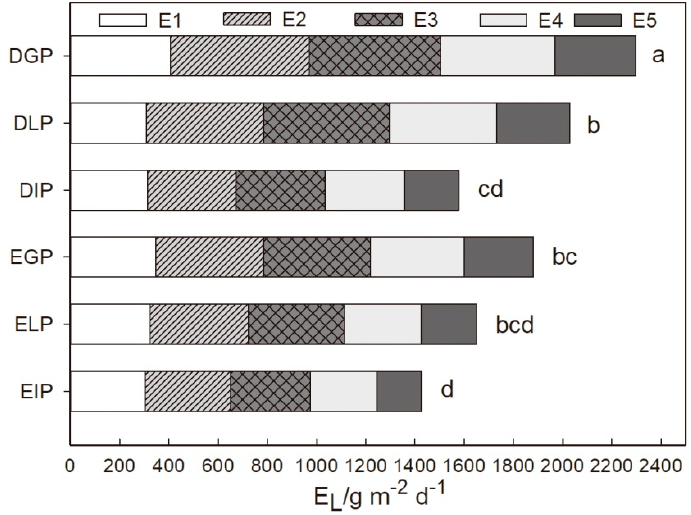
Figure 7. Total daily transpiration (E L ) of evergreen tree species (ET) and deciduous tree species (DT) in three configuration modes. E L = E1 + E2 + E3 + E4 + E5. E1: 8–10 h, E2: 10–12 h, E3: 12–14 h, E4: 14–16 h, E5: 16–18 h; Group planting of deciduous (DGP); linear planting of deciduous (DLP); individual planting of deciduous (DIP); group planting of evergreen (EGP); linear planting of evergreen (ELP); individual planting of evergreen (EIP). Different letters on the bars indicate significant differences at the 5% which are Duncan’s multiple comparison test groups for one dimensional ANOVA.